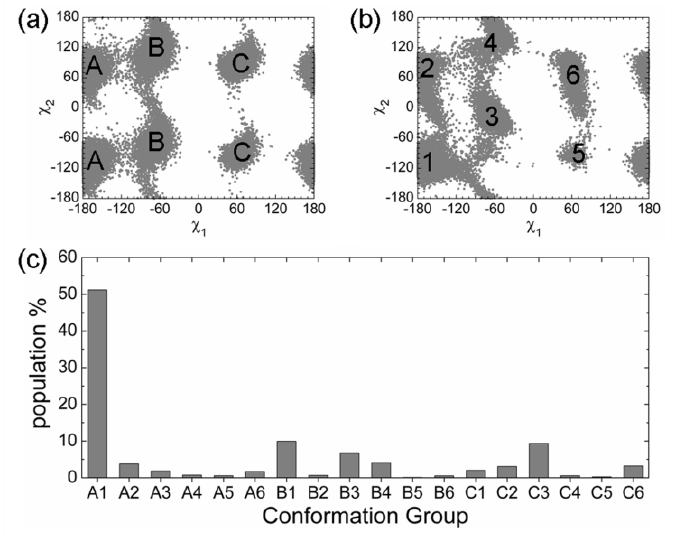
Figure 4. Combined analysis of the conformations of Phe19 and Trp23 in the helix state. ( a ) Side chain dihedral distribution of Phe19; ( b ) Side chain dihedral distribution of Trp23; ( c ) The combination of conformations of Phe19 and Trp23.